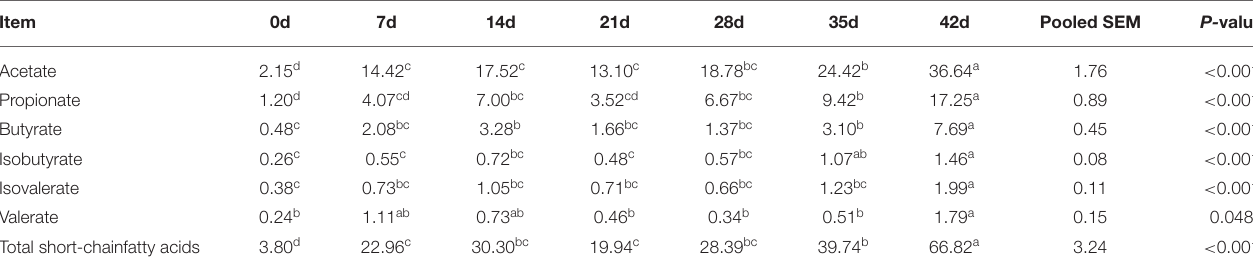
TABLE 3 | Effect of piglet age on the yield of short-chain fatty acids ( µ mol/g of wet digesta) in colonic digesta. Item